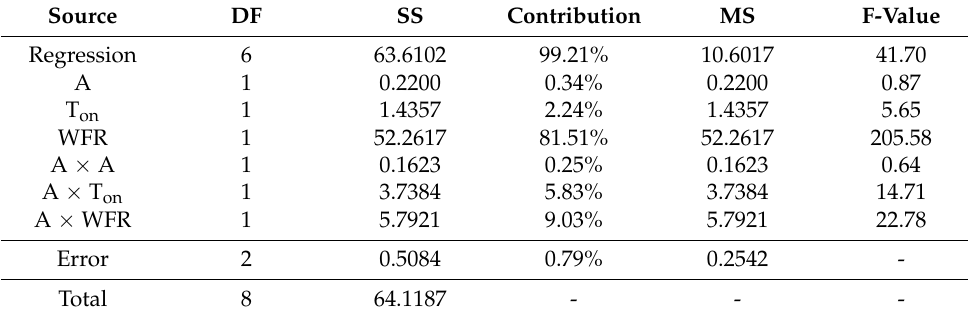
Table 4. Analysis of variance: surface roughness—Al6351–5% SiC–3% B4C.